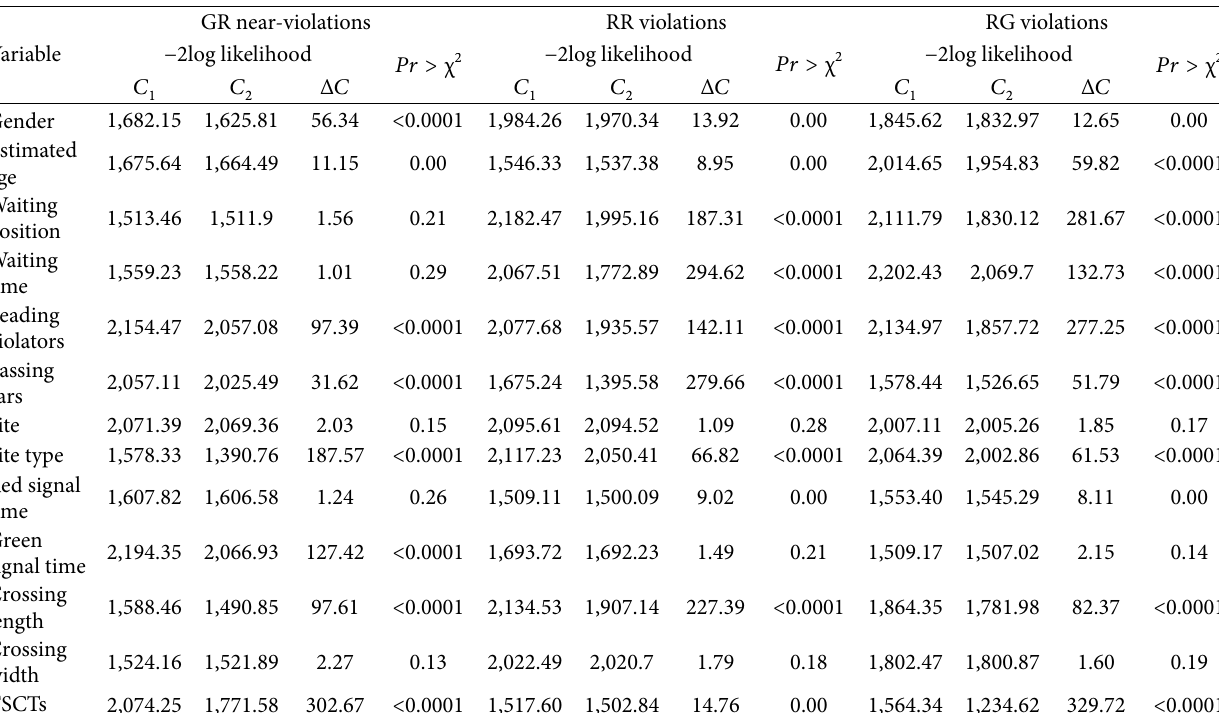
Table 6: Results of the univariate